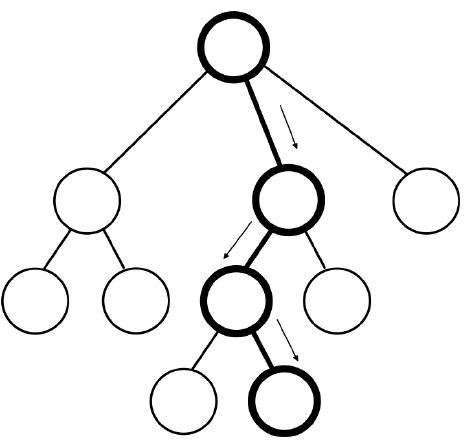
Figure 2. Selection phase in